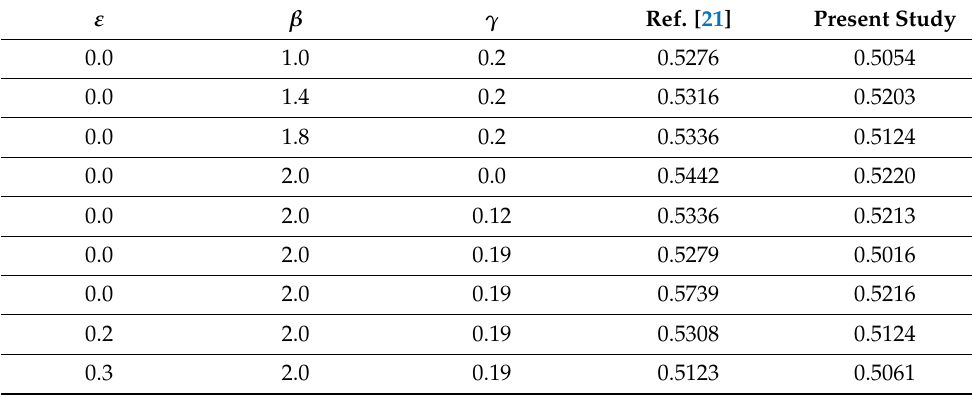
Table 13. Comparison of Nusselt number with Ref.